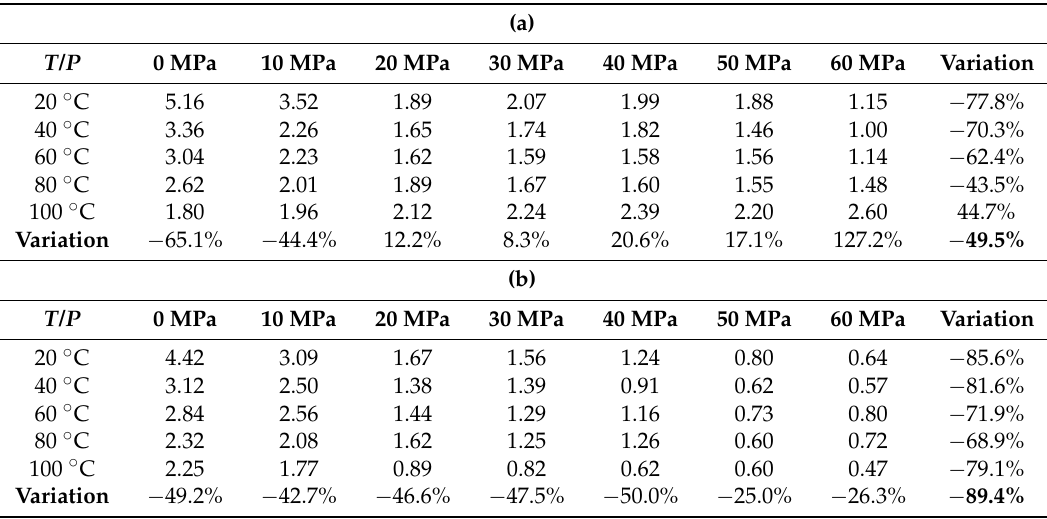
Table 6. ( a ) Detail of FOM k t 2 e 33 (C/m 2 ) for PIN-PMN-PT with variation in T and P ; ( b ) Detail of